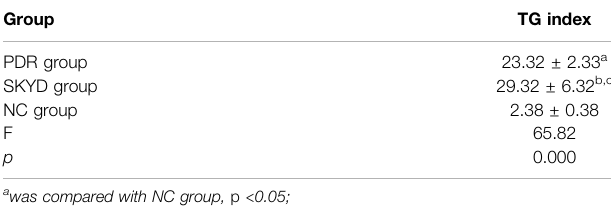
TABLE 1 | Total cholesterol index in three groups of mice (mean ± standard deviation).